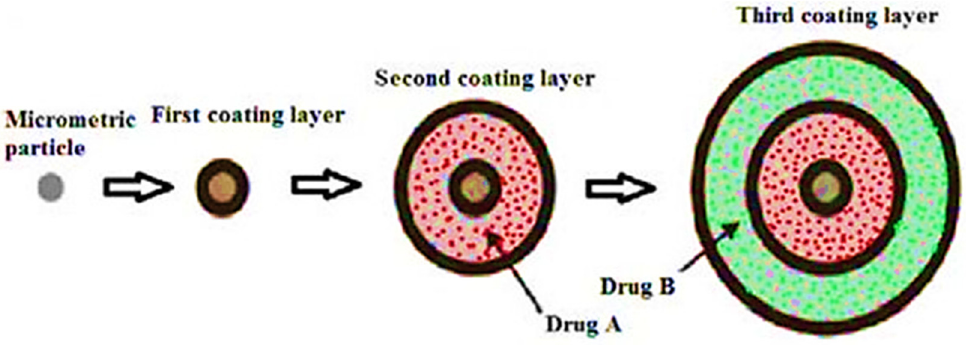
Figure 23. Layer-by-layer method. Reproduced with permission from [1].